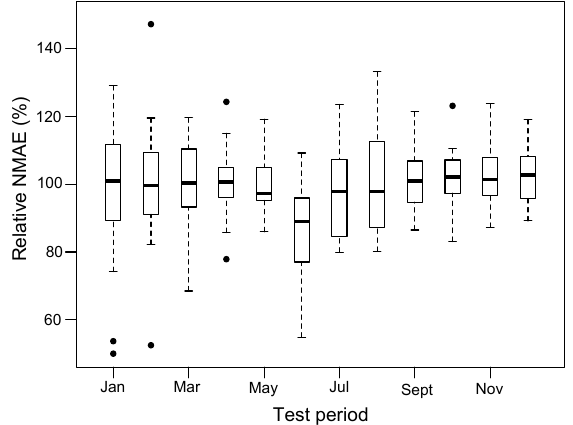
Figure 11. Boxplot of the forecasting performance depending on the exact test period. Each month of the year is, in turns, selected as the test period while the rest of the year is used as the training period. For each household in the Ξ subset, the NMAE obtained for each month is divided by the mean value obtained across the 12